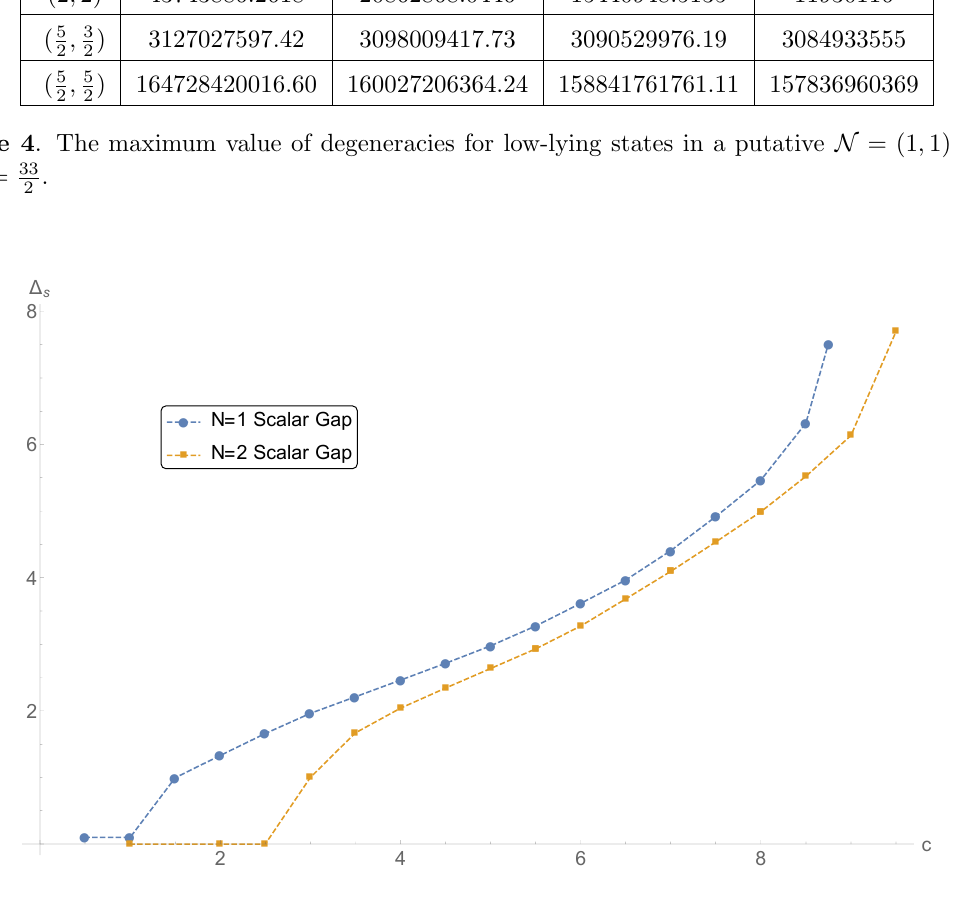
Figure 9 . Numerical upper bounds on the scalar gap for the N = (1 ; 1) and N = (2 ; 2) SCFTs.